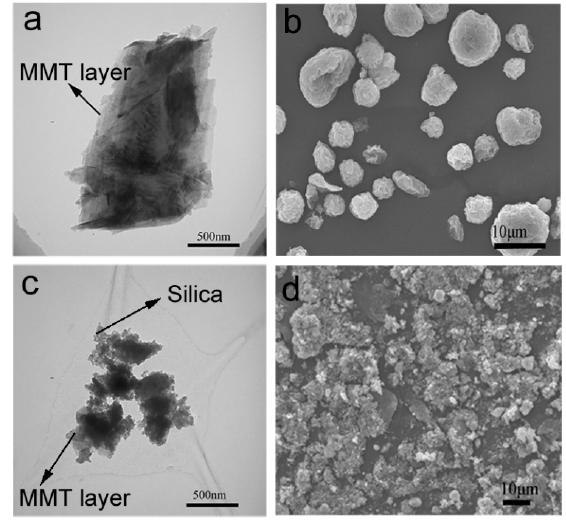
Figure 4. Transmission electron microscopy (TEM) and scanning electron microscope (SEM) images of MMT and silica/MMT nanocomposites. ( a ) TEM image of MMT; ( b ) SEM image of MMT; ( c ) TEM image of SMC-20 and ( d ) SEM image of SMC-20.